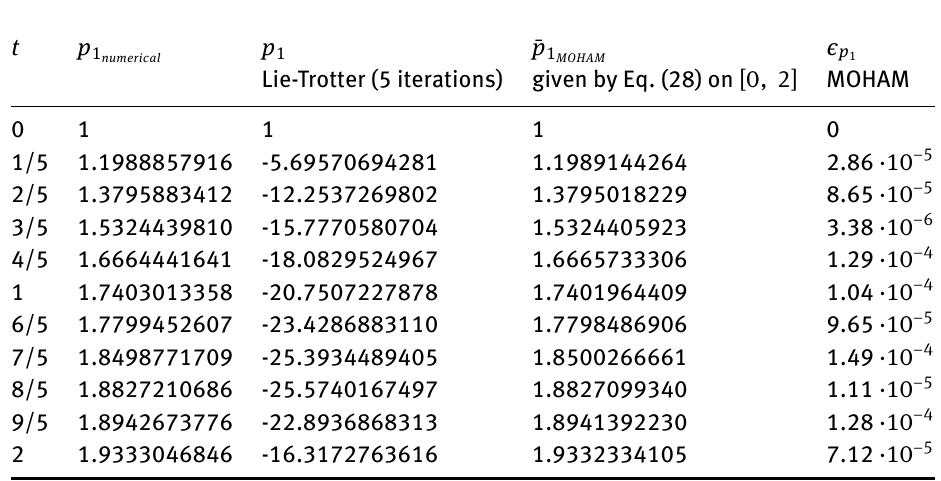
Table 4: The comparison between the approximate solutions ¯ p 1 given by Eq. (29) and the corresponding numerical solutions for a 1 = 10 , a 2 = 2 and a 3 = 3 (relative errors: ϵ p 1 = | p 1